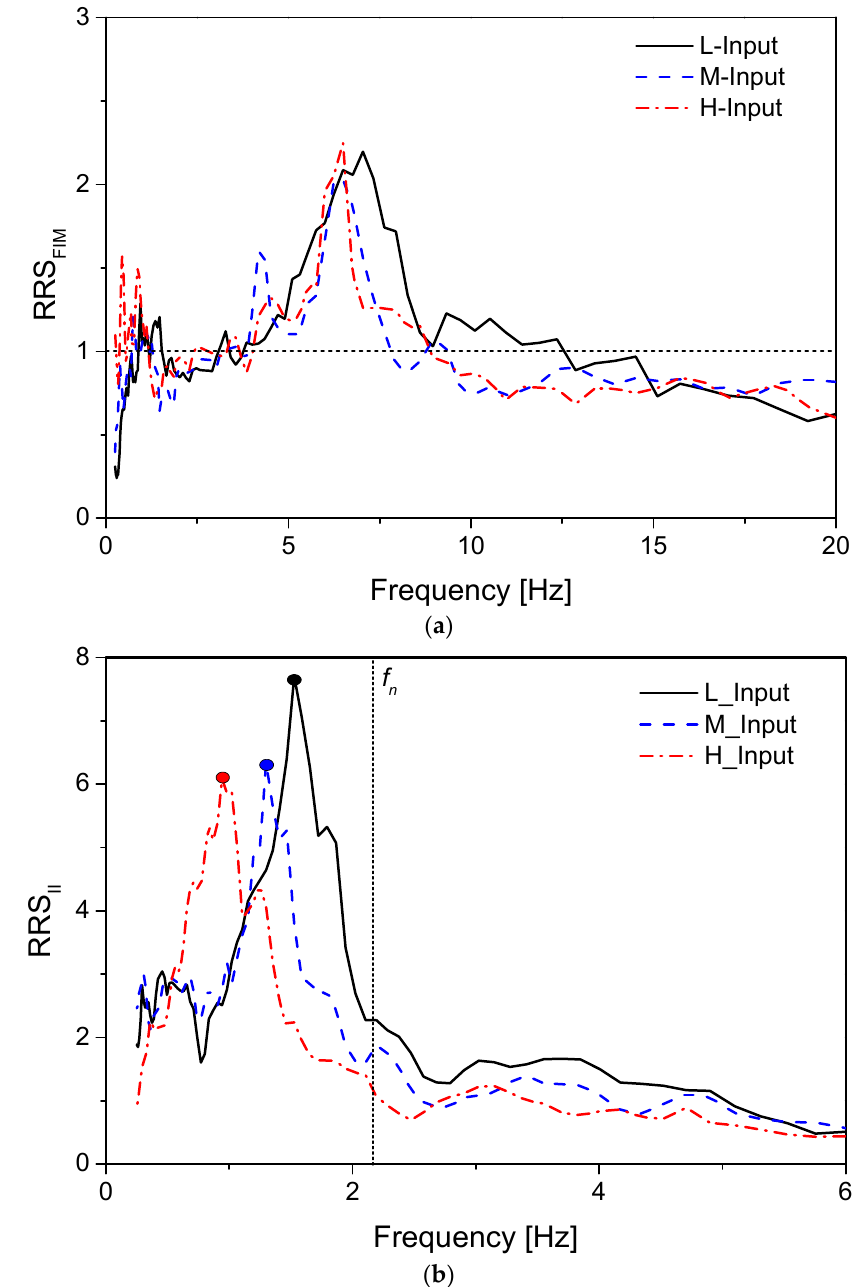
Figure 4. Ratio of response spectra (RRS) of S1 structure considering foundation input motion (RRS FIM ) ( a ) and inertia interaction (RRS II ) with artificial input motion ( b ). f n is fixed‐base frequency of S1 structure. Solid circles indicate peak RRS of each case.